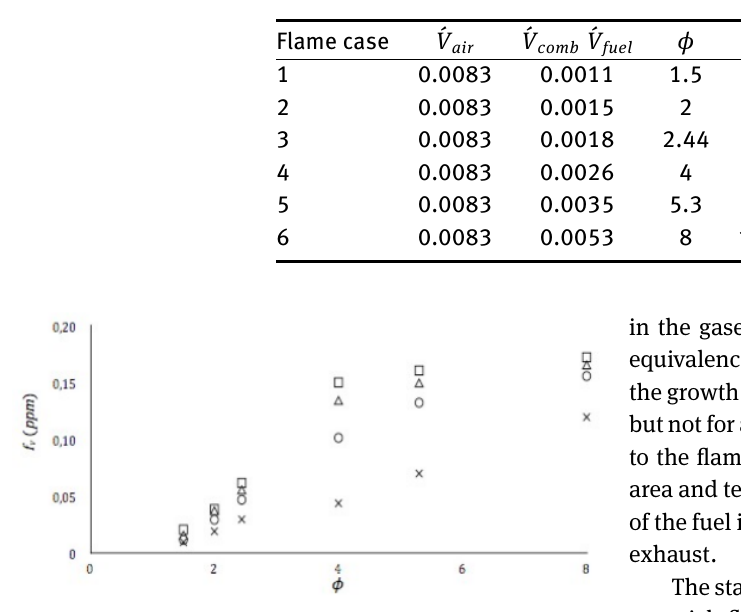
Table 1: Flames configurations.